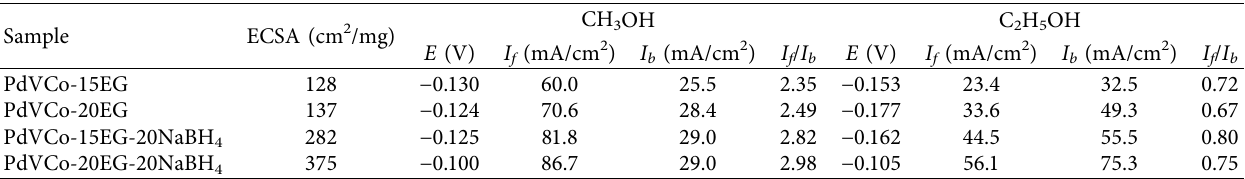
Figure 4: CVs of nanocatalysts PdVCo in 1 M KOH at a scan rate of 50mV/s. Table 3: Electrochemical parameters from alcohol oxidation of nanocatalysts